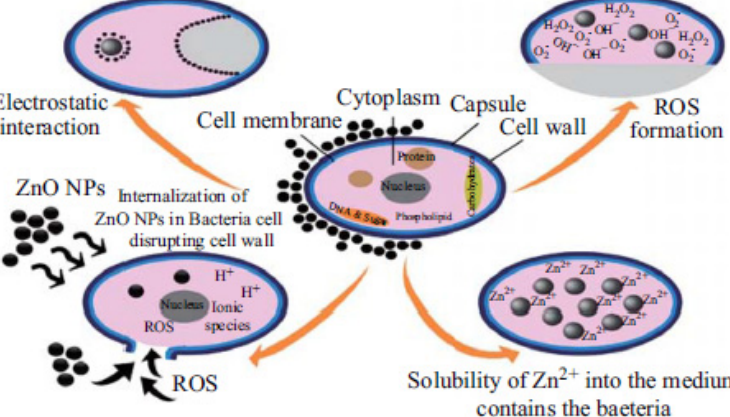
Figure 6. Multiple antibacterial mechanisms that are associated with ZnO nanoparticles. (Adapted with permission from Ref. [222]. 2015, Sirelkhatim et al. More details on “Copyright and Licensing” are available via the following link: https://www.mdpi.com/ethics#10 (accessed on 10 October